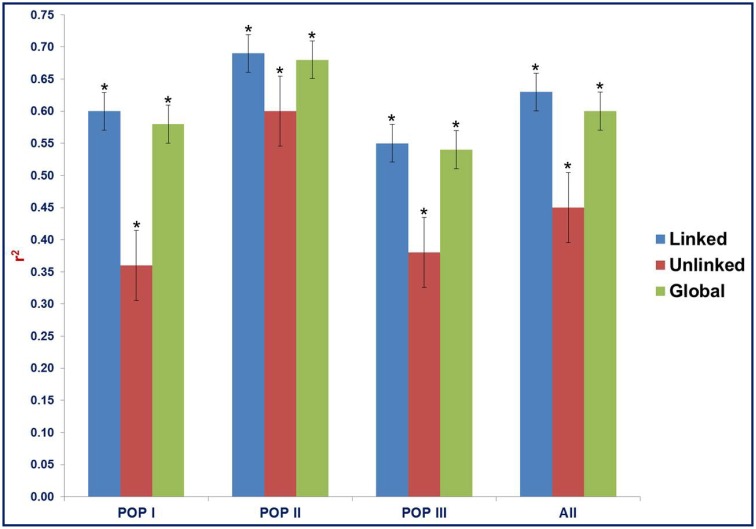
Estimates of LD (mean r2) for linked, unlinked, and global markers (3321 desi and 8592 kabuli SNPs) in three populations as defined by the population genetic structure. “All” includes the LD estimates and decay across three populations. The bar indicates the standard error. *ANOVA significance at p < 0.001.